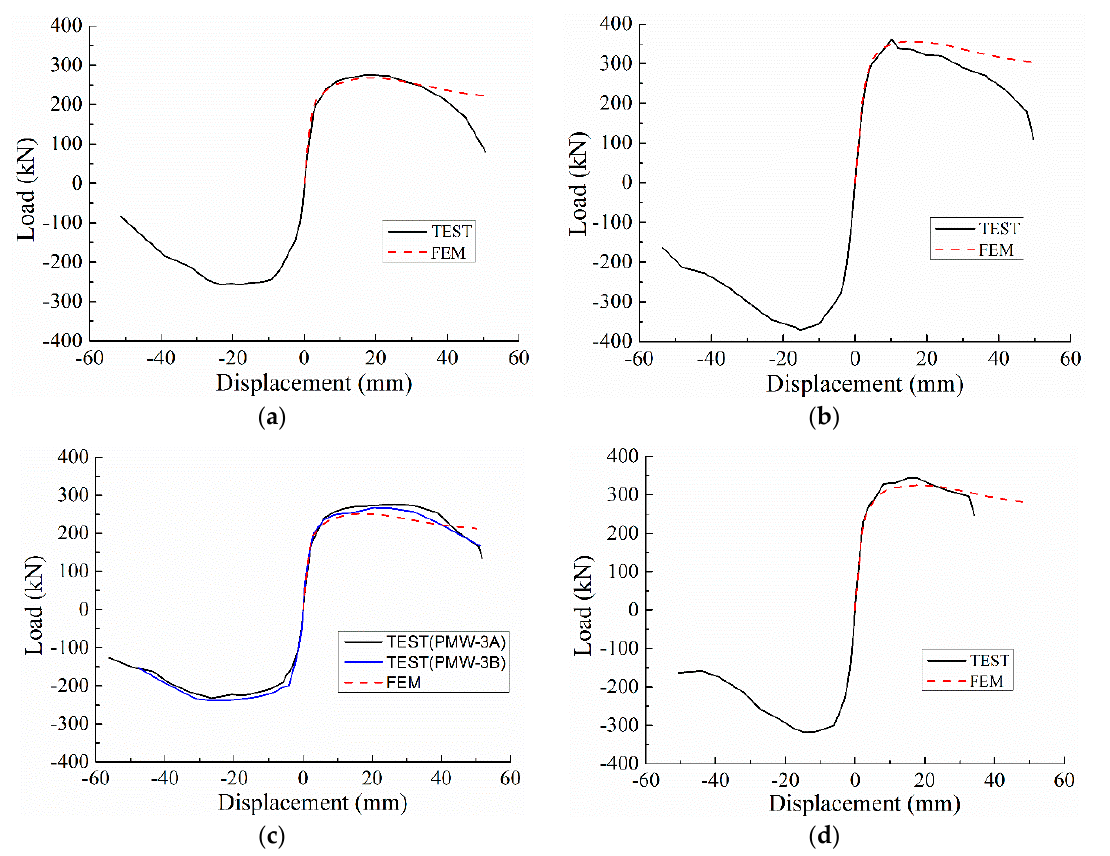
Figure 17. Envelope curves of test results and numerical analysis: ( a ) PMW-1; ( b ) PMW-2; ( c ) PMW-3A/B; and ( d )